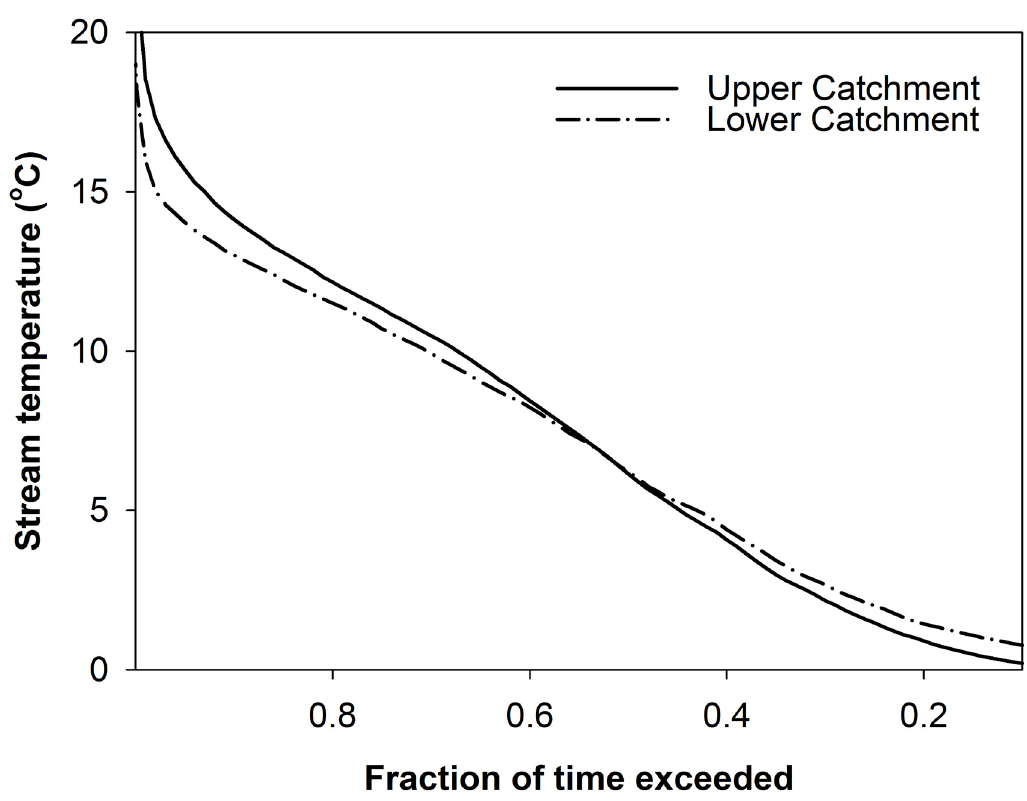
Fig 3. Stream temperature exceedance curve for the upper and lower catchment sites. This is the proportion of time at which a particular temperature is equalled or exceeded.